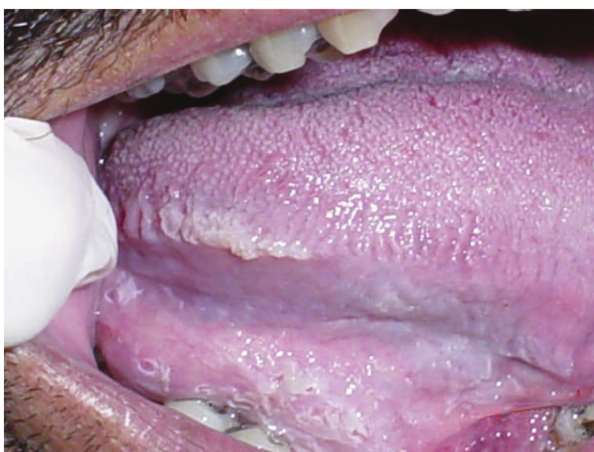
Figure 6 - Lateral border of tongue and floor of the mouth after 2 weeks of peroxide mouthwash.